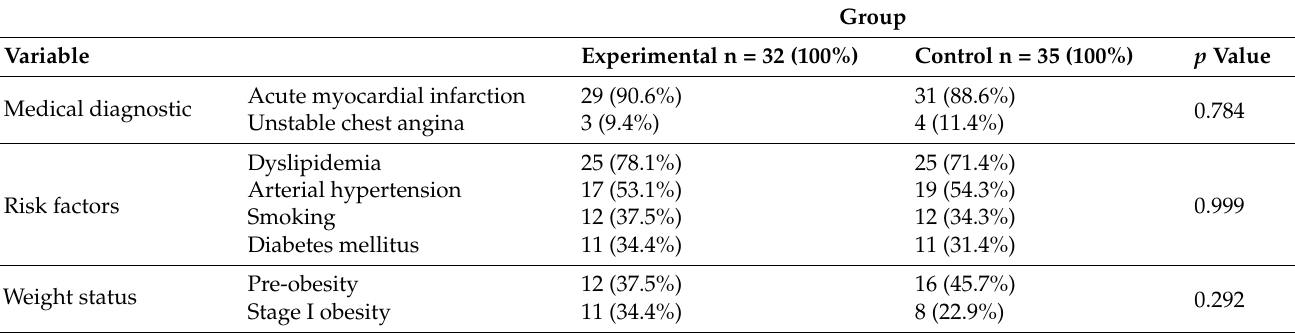
Table 4. Clinical characteristics of the groups.